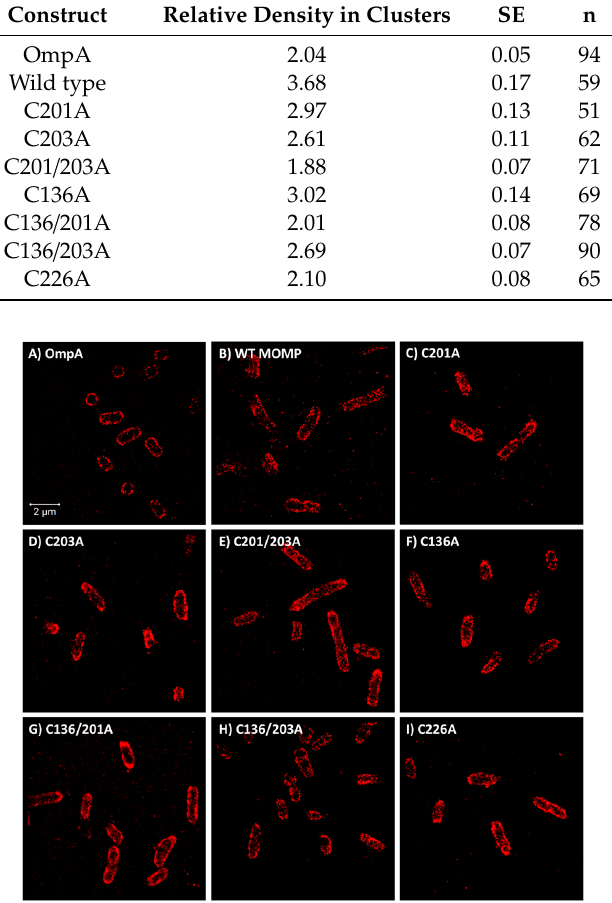
Figure 3. Super-resolution dSTORM images of E. coli cells. ( A ) E. coli anti-OmpA; ( B ) wild-type rMOMP; Figure 3. Super ‐ resolution dSTORM images of E. coli cells. ( A ) E. coli anti ‐ OmpA; ( B ) wild ‐ type ( C ) rMOMP C201A; ( D ) rMOMP C203A; ( E ) rMOMP C201 / 203A; ( F ) rMOMP C136A; ( G ) rMOMP rMOMP; ( C ) rMOMP C201A; ( D ) rMOMP C203A; ( E ) rMOMP C201/203A; ( F ) rMOMP C136A; ( G ) C136 / 201A; ( H ) rMOMP C136 / 203A; and ( I ) rMOMP C226A. All cells were induced for a total of 3 h, rMOMP C136/201A; ( H ) rMOMP C136/203A; and ( I ) rMOMP C226A. All cells were induced for a with rMOMP-expressing cells labelled with an anti-His Alexa Fluor 647 antibody and OmpA first with total of 3 h, with rMOMP ‐ expressing cells labelled with an anti ‐ His Alexa Fluor 647 antibody and anti-OmpA primary antibody coupled with an anti-647 secondary antibody. Localisation precision OmpA first with anti ‐ OmpA primary antibody coupled with an anti ‐ 647 secondary antibody. histograms are provided in Supplementary Figure Localisation precision histograms are provided in Supplementary Figure S1.